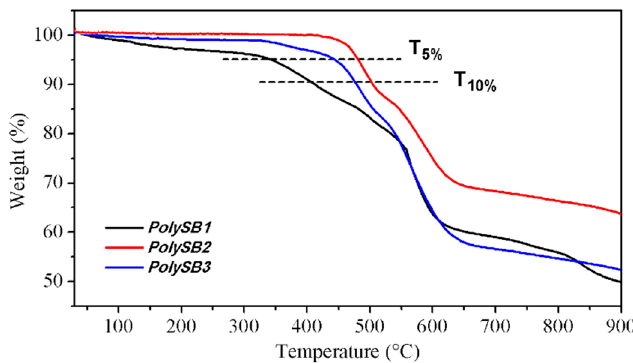
Figure 4. Thermal curves of polySBs with a heating rate of 10 °C min − 1 in a nitrogen atmosphere.